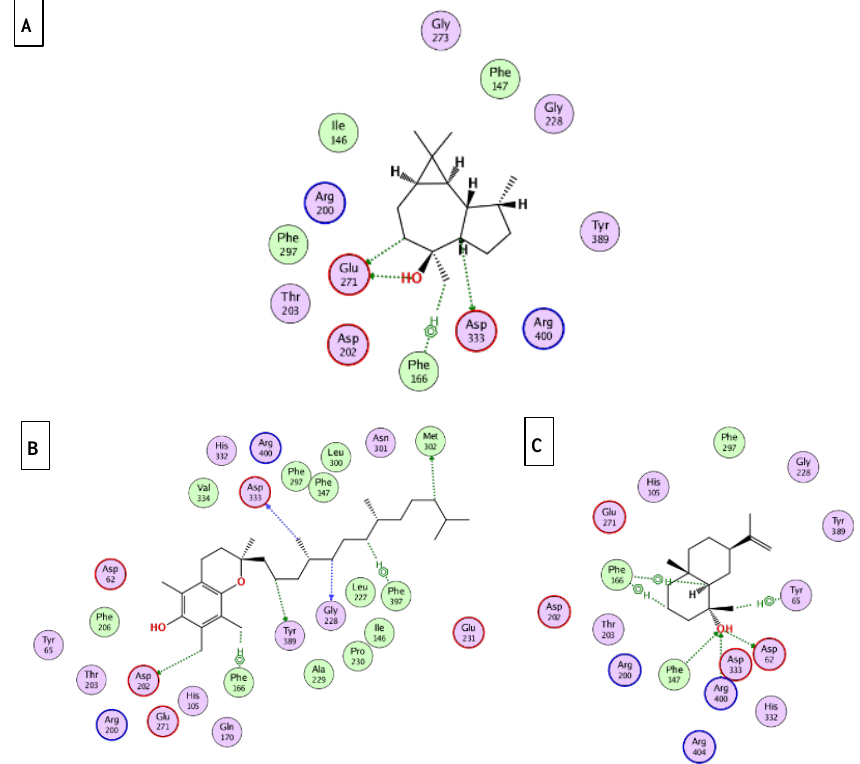
Figure 8. 2D binding modes of viridiflorol ( A ); α -tocopherol ( B ); selin-11-en-4- α -ol ( C ) to the active binding sites of α -glucosidase.